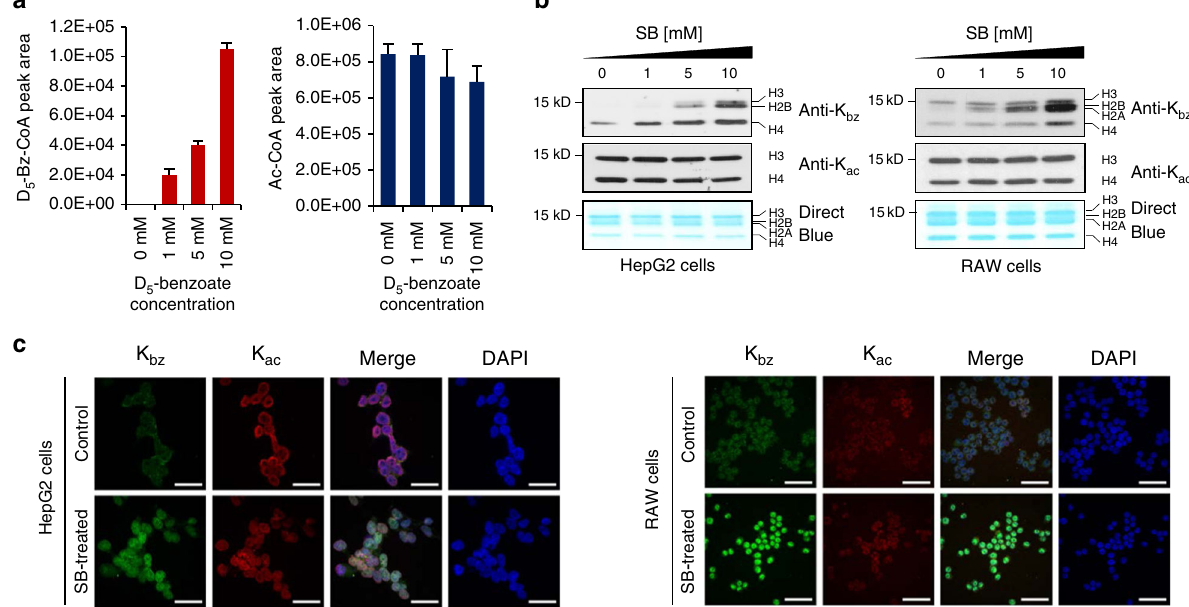
Fig. 4 Dynamics of histone K bz in eukaryotic cells. a HPLC-MS/MS analysis of cellular benzoyl-CoA levels extracted from HepG2 cells cultured with the indicated concentration of D 5 -SB (pH 7.4) for 24h ( n = 3, values are expressed as mean±s.d.). b Western blotting analysis of core histone K bz in response to SB with the indicated concentration in HepG2 (left) and RAW (right) cells. c The dynamics of K bz and K ac in response to SB treatment as determined by immuno fl uorescence staining using pan-K bz and pan-K ac antibodies. HepG2 (left) and RAW (right) cells were treated with 10mM of SB for 24h. Scale bar, 50 μ